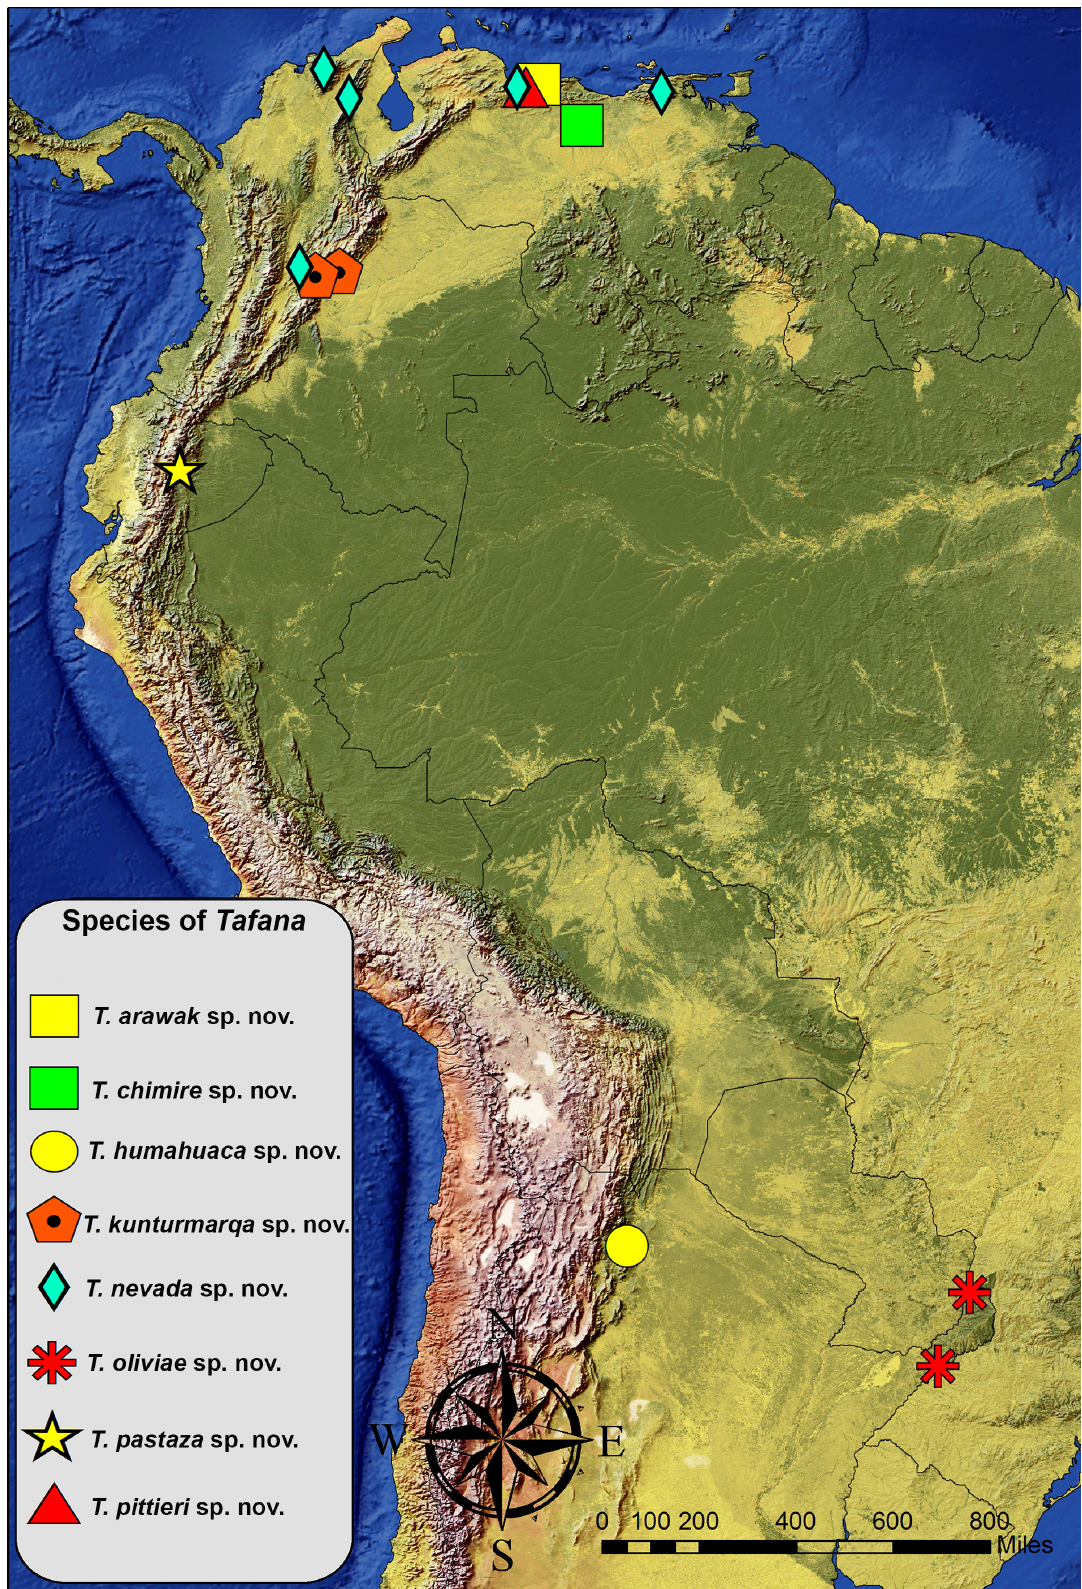
Fig. 35. Distribution map of species of Tafana